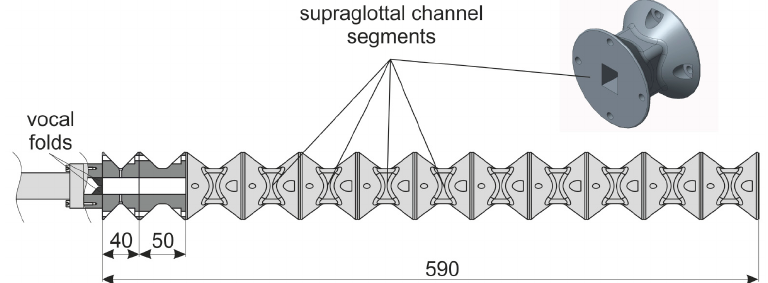
Figure 6. Segmented vocal tract model used to vary the length of the vocal tract (distances are in millimeters).